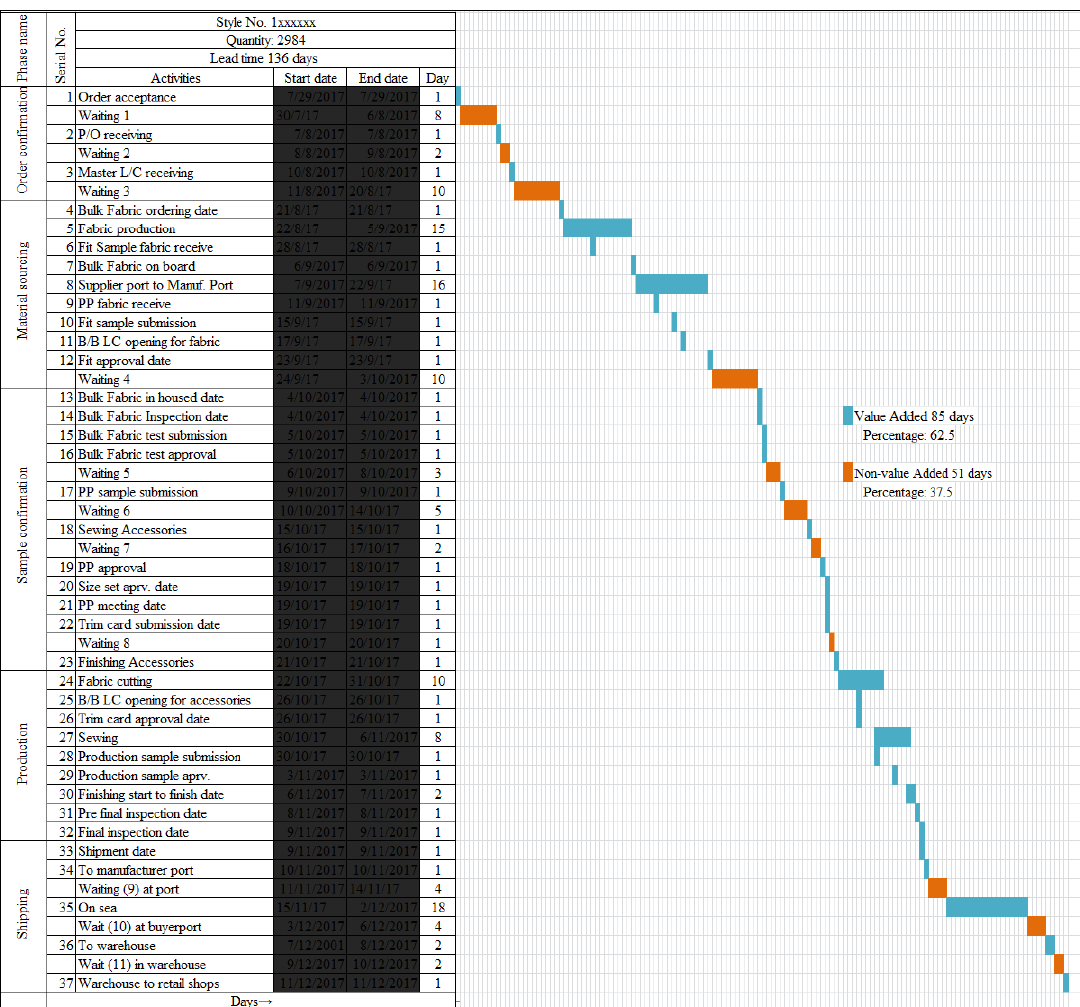
Figure 3. Time based process mapping